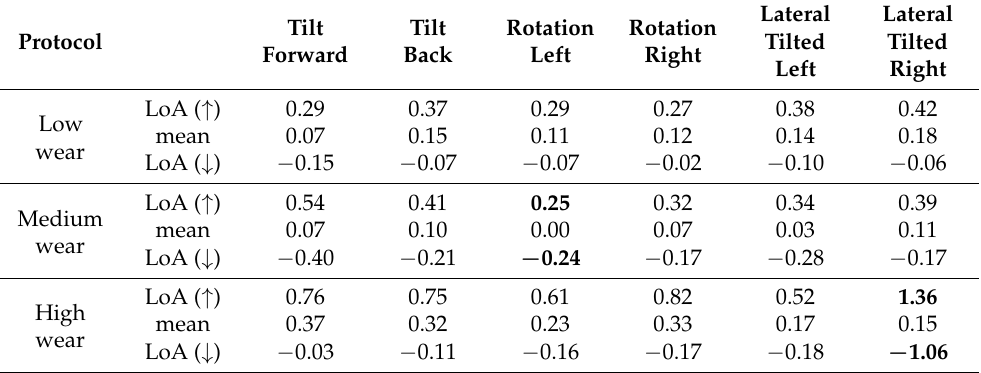
Table 3. Mean value with upper and lower LoA for six changed pelvic